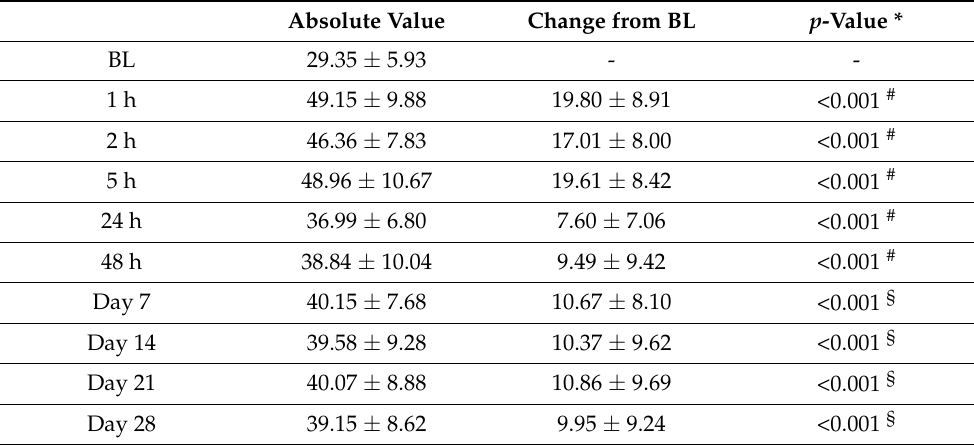
Table 7. Absolute skin capacitance measurement values and changes from baseline after single application of Emollient 3 (first 48 h) followed by once-daily application for 26 days. Absolute Value Change from BL p -Value *